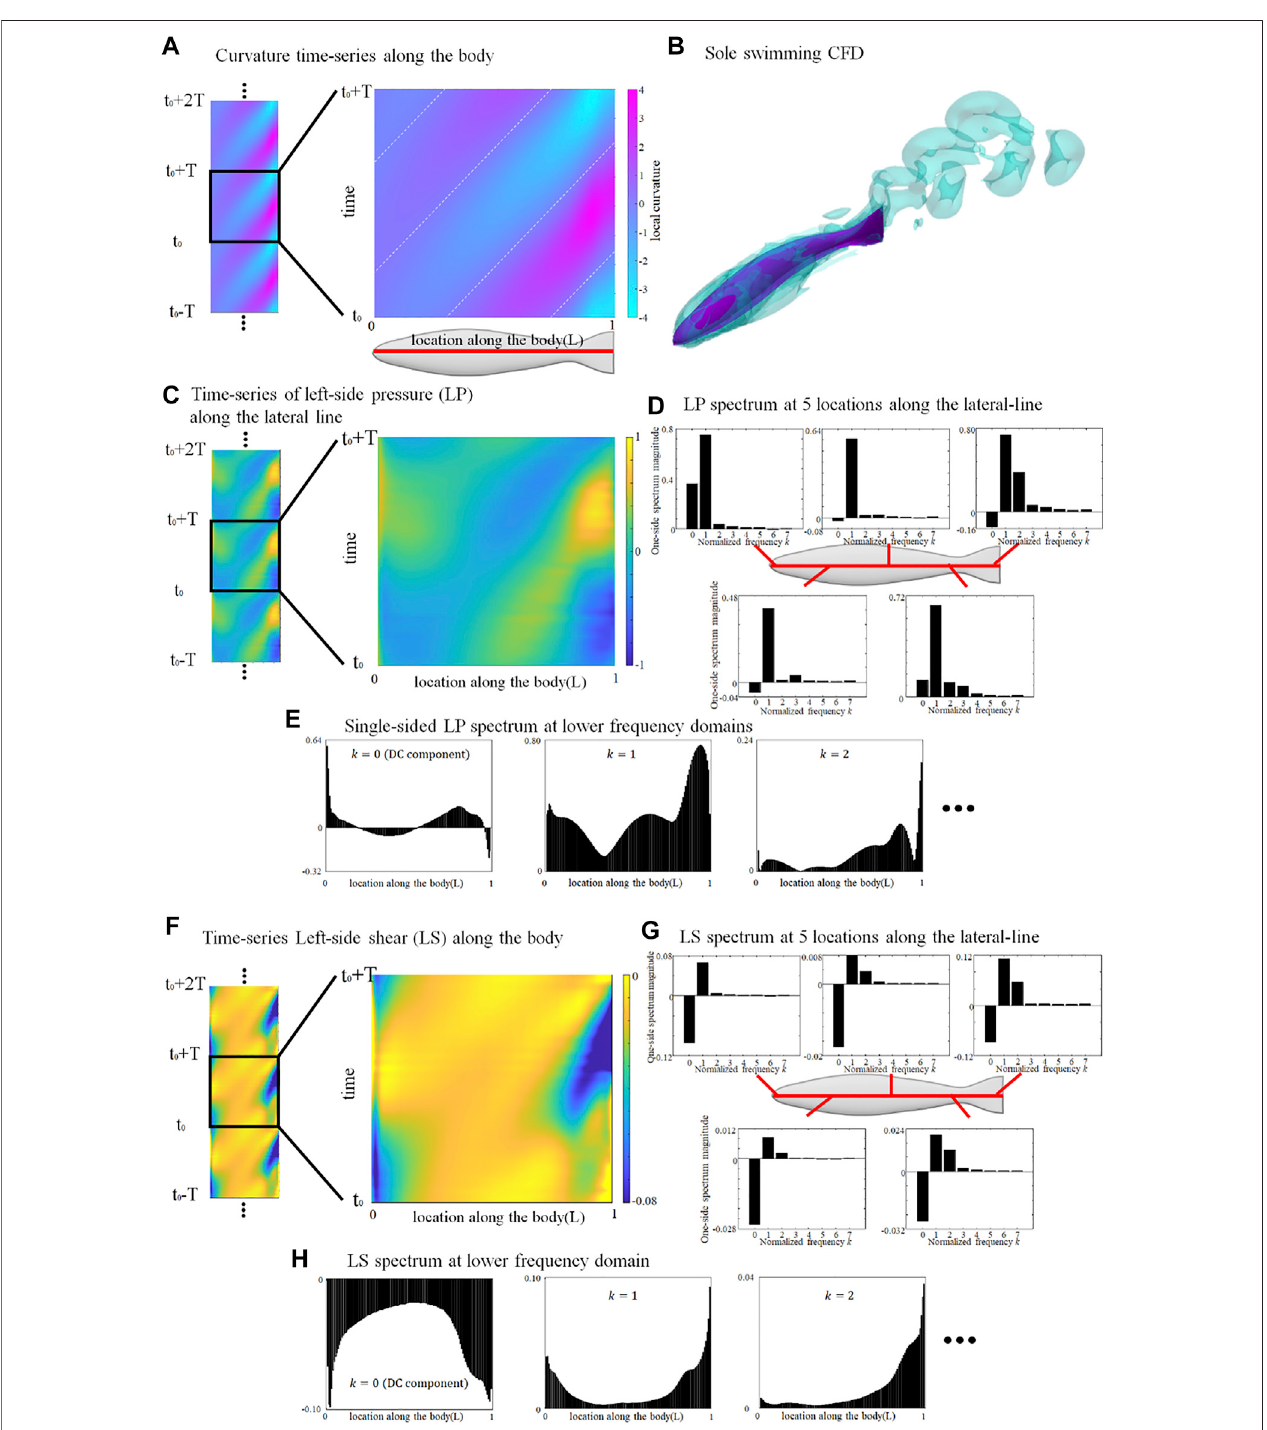
FIGURE 1 | Deformation and lateral-line stress in solely swimming fi sh. (A) curvature map of fi sh axis in an arbitrary tail-beat cycle (from t 0 to t 0 + T ); (B) Flow fi eld surroundingasolelyswimming fi sh; (C) pressure-stressmapoftheleft-sidelateral-line; (D) Frequencydomainanalysisofpressurestresssignalat fi velocationsalongthe lateral-line; (E) Distribution of single-sided spectrum of left-side pressure, at k = 0, 1, and 2; (F) shear-stress map of the left-side lateral-line; (G) Frequency domain analysisofshear-stress signal at fi ve locations alongthe lateral-line; (H) Distributionof single-sided spectrum ofleft-sideshear-stress signal,at k = 0, 1, and 2. One stress unit = 10